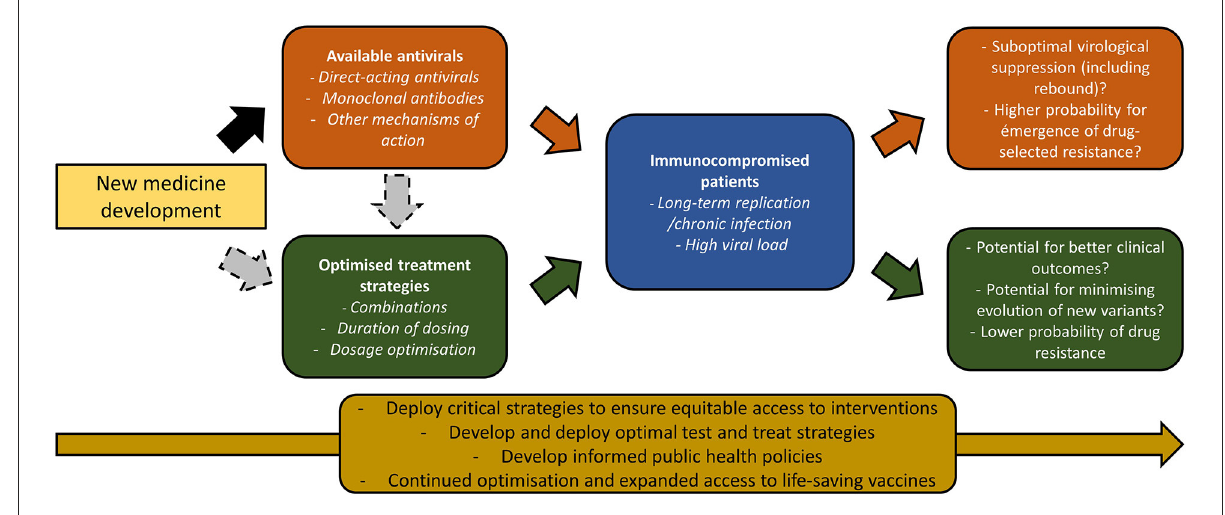
FIGURE1 Potential impact of SARS-CoV-2 antiviral drugs optimization in protecting available antivirals in the shifting landscape of new variants.